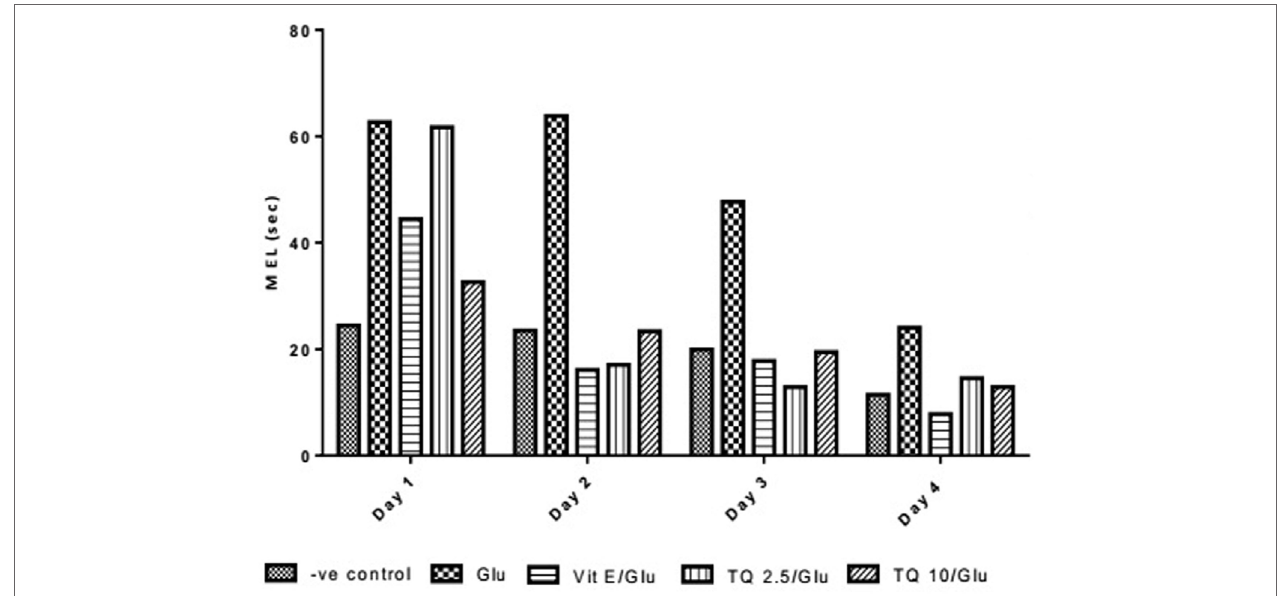
FigUre 7 | Effect of Glu, Vit E/Glu, TQ2.5/Glu, and TQ10/Glu on lactate dehydrogenase levels. Glu was injected i.p. as a single dose for 7 days. TQ and Vit E were injected as a single dose for 7 days. Each value represents the mean value of 12 rats ± SEM. Statistics were carried out by one-way ANOVA followed by Tukey’s multiple comparison tests, by graph pad prism 5. *Statistically significant from − ve control group ( p < 0.05); @ statistically significant from Glu group ( p < 0.05); # statistically significant from Vit E/Glu group ( p < 0.05); X statistically significant from TQ 2.5/Glu group ( p <